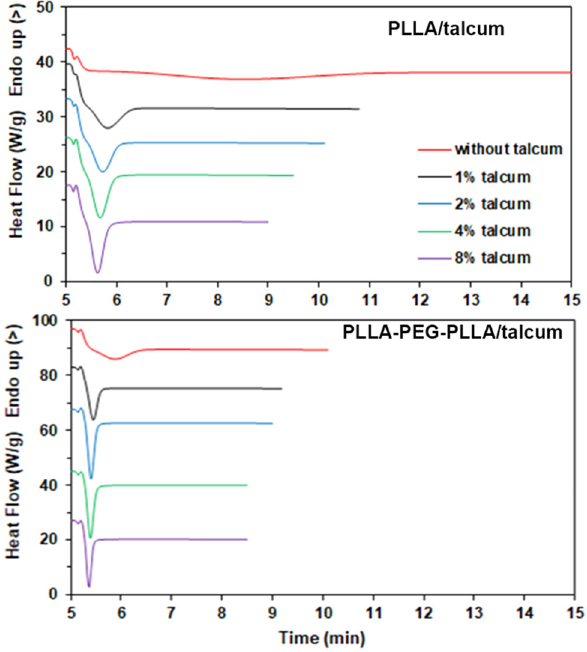
Figure 3: DSC isothermal curves at 120°C of ( above ) PLLA/talcum and ( below ) PLLA - PEG - PLLA/talcum composites for various talcum